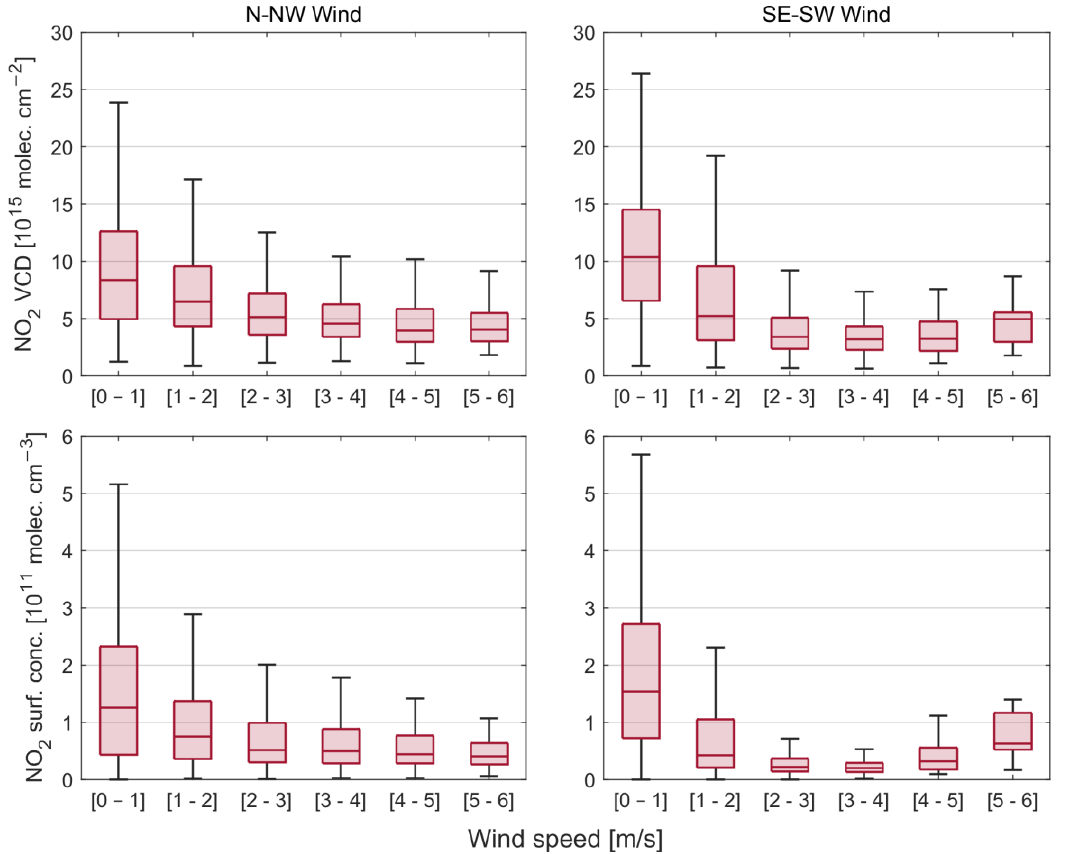
Figure A3. Tropospheric vertical columns ( upper panels) and surface concentrations ( bottom panels) of NO 2 as a function of wind speed. The left and right columns correspond to N – NW and S – SW wind directions, respectively.